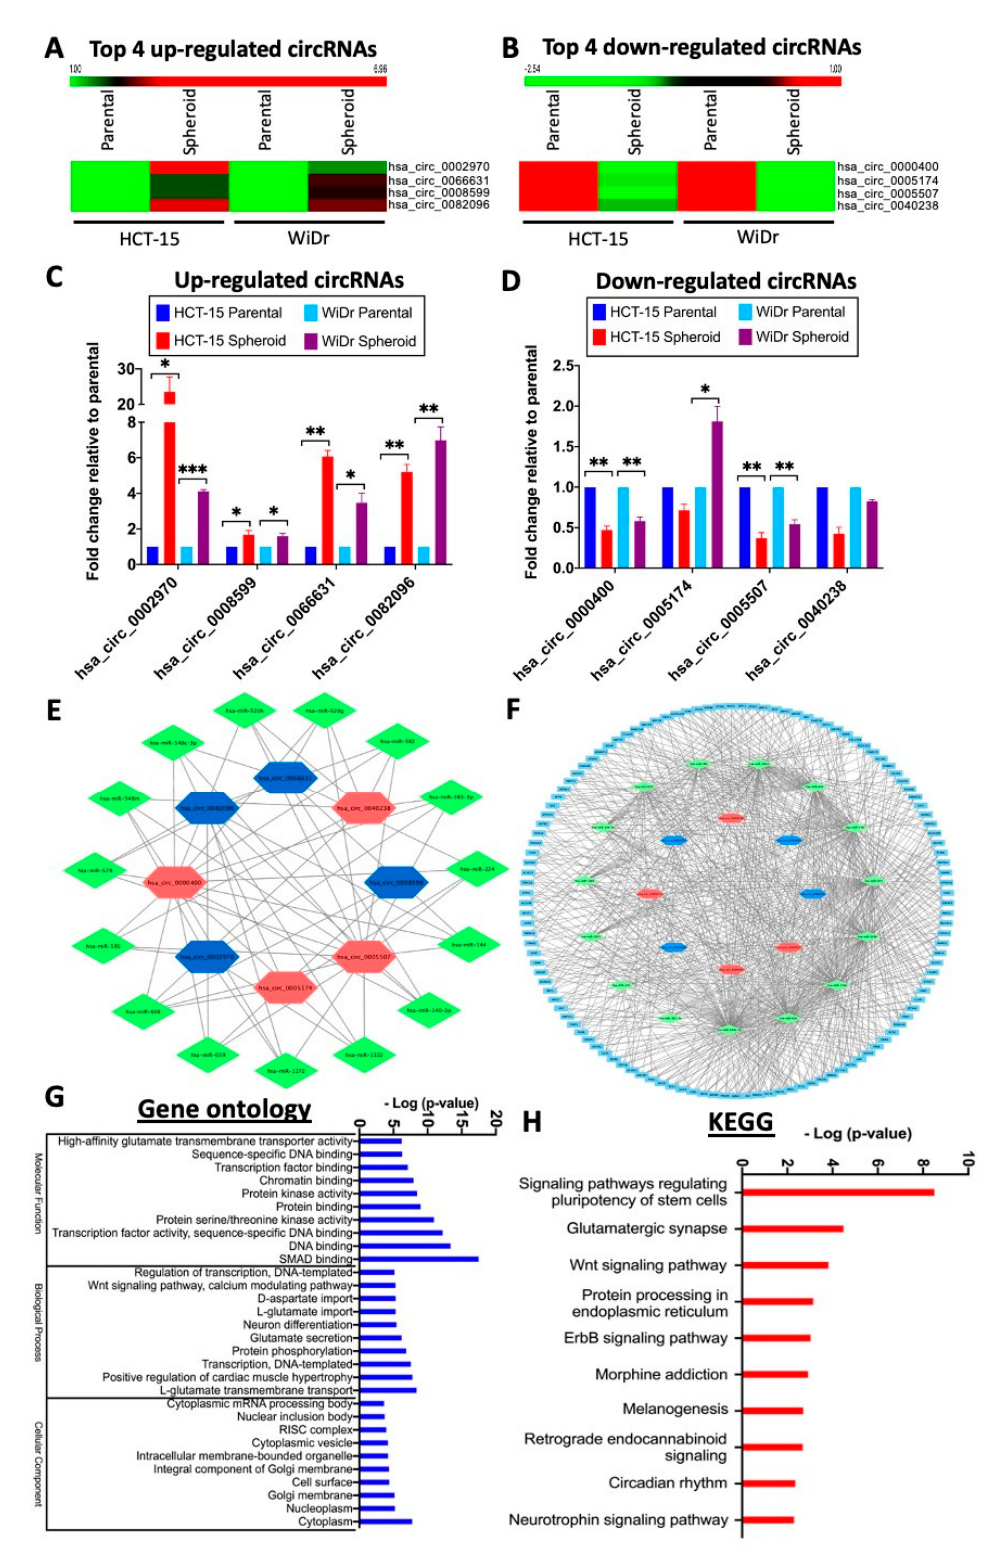
Figure 4. The top eight di ff erentially expressed circular RNAs (circRNAs) form a core circRNA–microRNA (miRNA)–mRNA network to regulate stemness. ( A , B ) Hierarchical clustering analysis of top 4 up- ( A ) and down-regulated ( B ) circRNAs in the spheroid cells relative to the CRC cells. ( C , D ) Validation, by qRT-PCR, of the NGS expression data of the up- ( C ) or down-regulated ( D ) circRNAs in the spheroids; * p < 0.05, ** p < 0.01 and *** p < 0.001 were values relative to the parental cells. ( E – H )